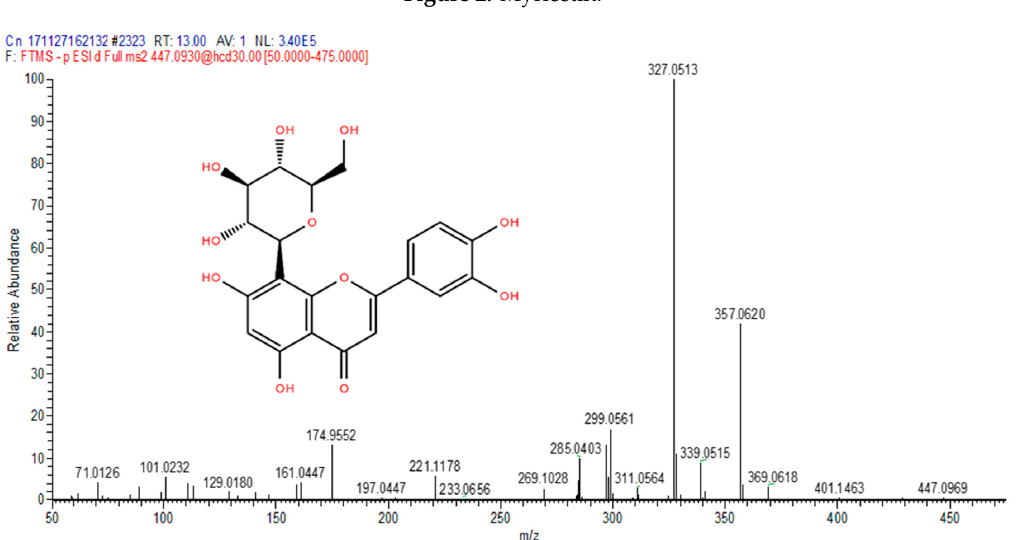
Figure 3. Orientin.